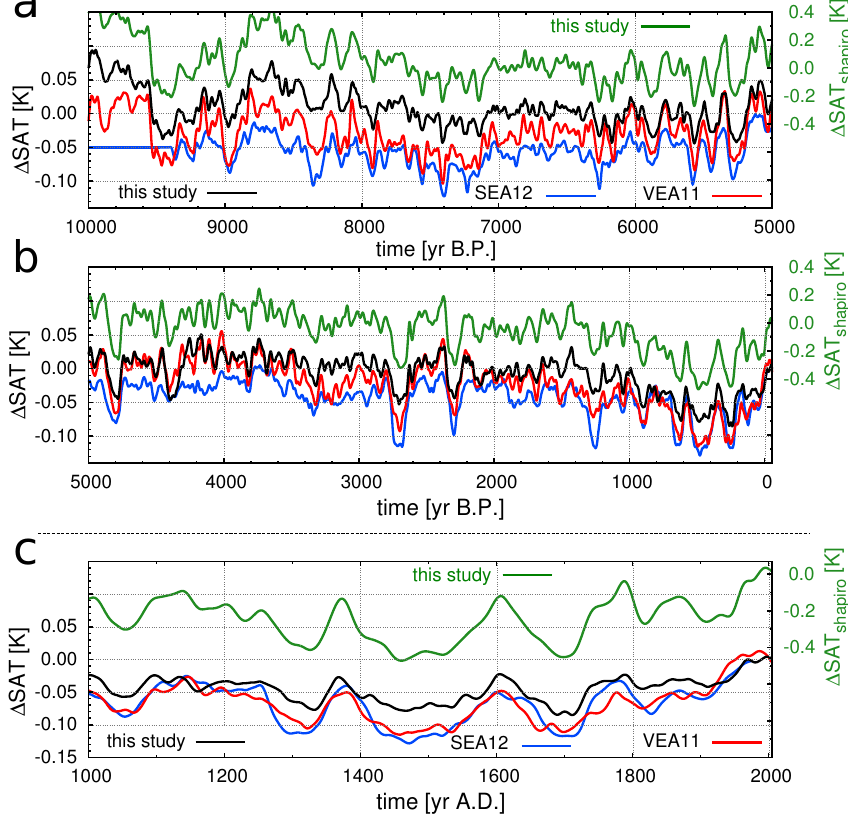
Fig. 16. (a, b) Simulated changes in SAT as a response to different TSI forcings: this study (black), VEA11 (red) and SEA12 (blue), left y axis. The green line (right y axis) shows the simulated SAT changes by a solar variation based on our 8 history but converted to TSI using the method of Shapiro et al. (2011). The anomalies were calculated as the difference between two transient simulations, one with all forcings and the other with the same forcings but solar forcing taken to be constant. The last 1000yr are shown again in (c) . All lines show smoothing splines with a cutoff period of